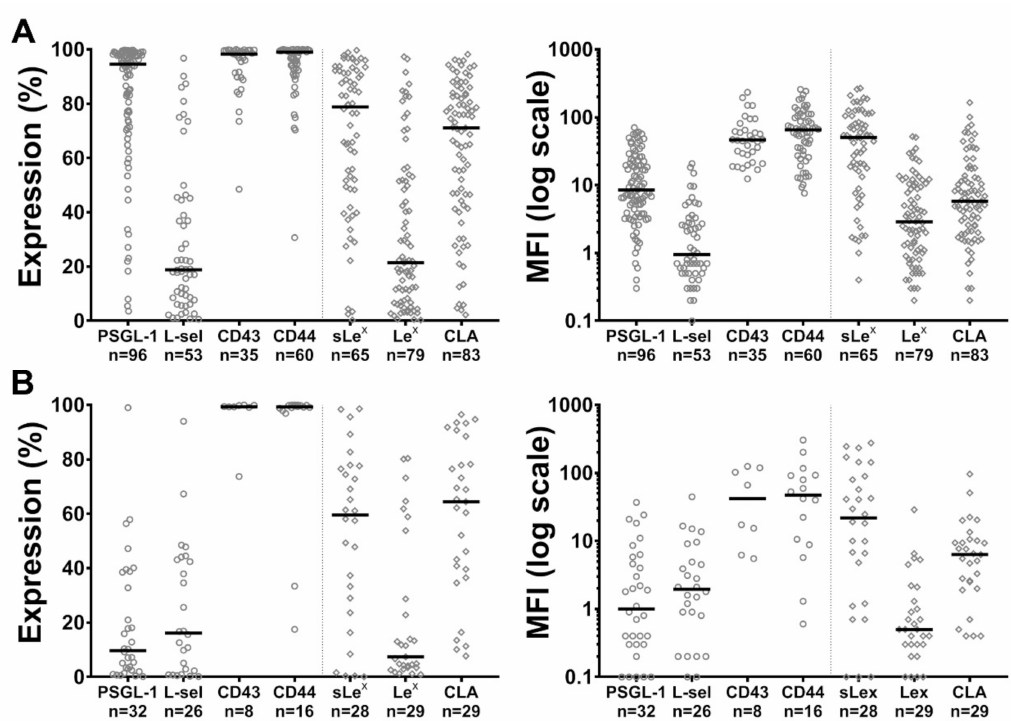
Figure 1. Expression levels in ( A ) acute myeloid leukemia and ( B ) acute lymphoblastic leukemia of P-selectin glycoprotein ligand 1 (PSGL-1), L-selectin, CD43, CD44, and carbohydrate determinants sialyl Lewis x (sLe x ), Lewis x (Le x ) and cutaneous lymphocyte antigen (CLA). Acute myeloid leukemia (AML) and acute lymphoblastic leukemia (ALL) blast cells were immunostained with specific monoclonal antibodies (mAbs) and expression levels (%) and mean fluorescence intensities (MFI), determined by flow cytometry, were plotted after substraction of the background of their respective